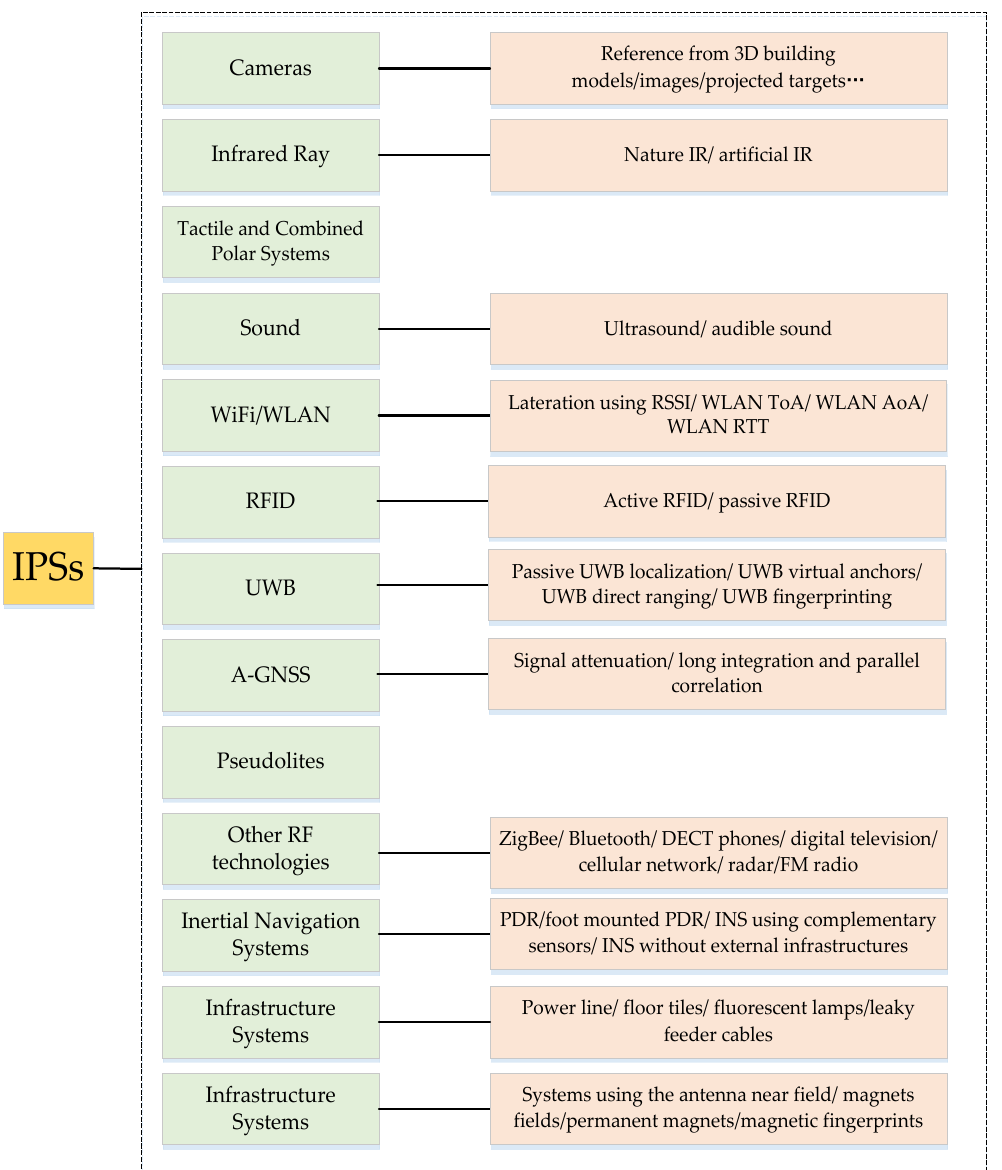
Figure 2. Indoor positioning technologies categorized by Mautz [33].